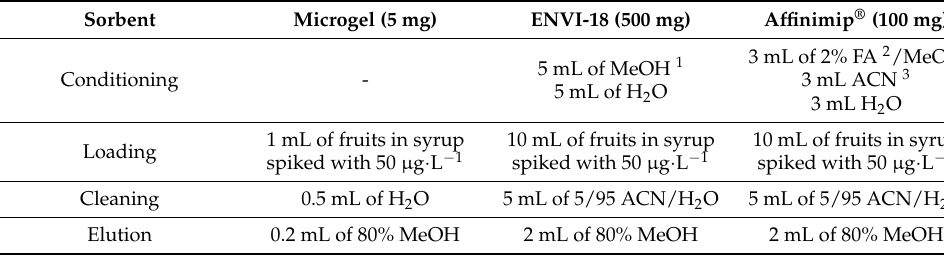
Table 3. Solid-phase extraction methods used for preconcentration of fruits in